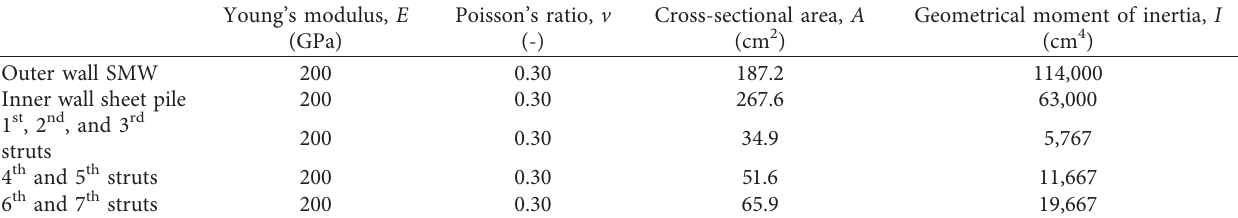
Table 3: Physical and mechanical properties of earth retaining wall and struts.